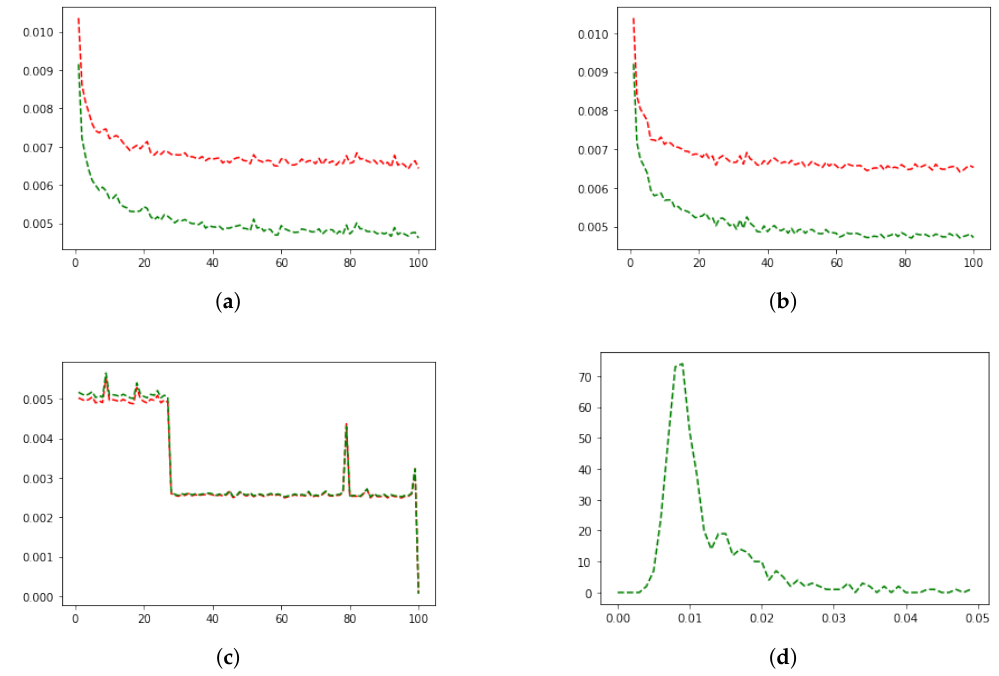
Figure 4. Cases with two scatterers, Mean square error ( a – c ) for each group of test data and distribu- tion of mean square error of test data ( d ).